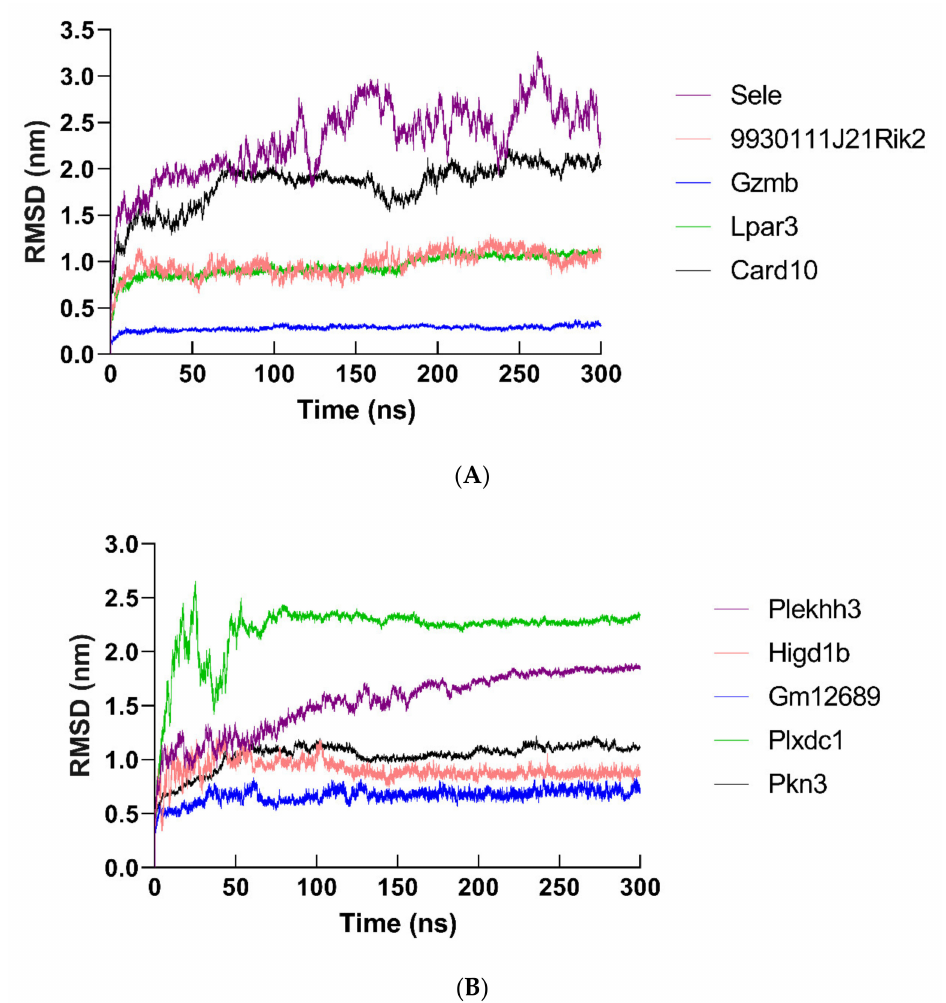
Figure 16. RMSD data of backbone C α atoms in molecular dynamics simulation (300 ns). RMSD plots of hub proteins were shown, including ( A ) SELE, 9930111J21RIK2, GZMB, LPAR3, CARD10, ( B ) PLEKHH3, HIGD1B, GM12689, PLXDC1, and